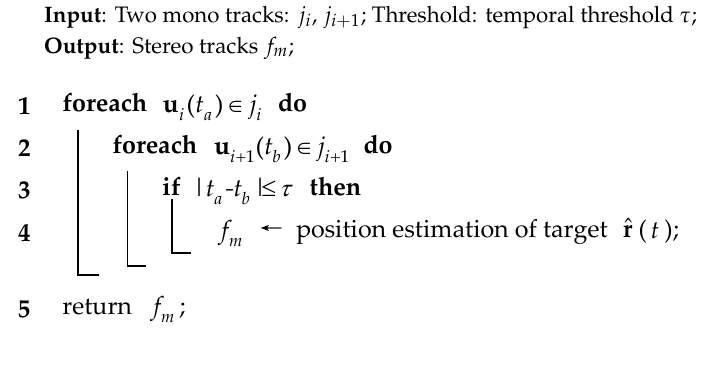
Algorithm 1: Pairwise fusion algorithm